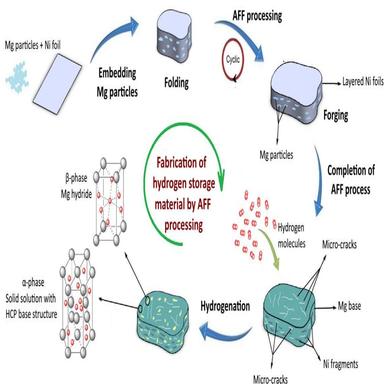
e Schematic for the correlation between structural restoration upon AFF consolidation with the produced layered materials' extrinsic mechanical and chemical behaviors.